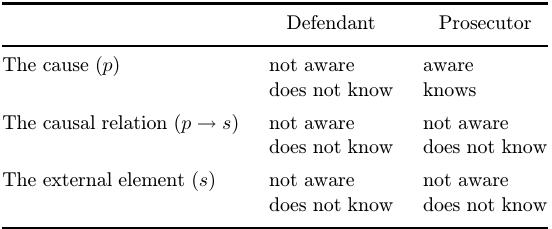
Table 3. Comparison of epistemic statuses between defendant and